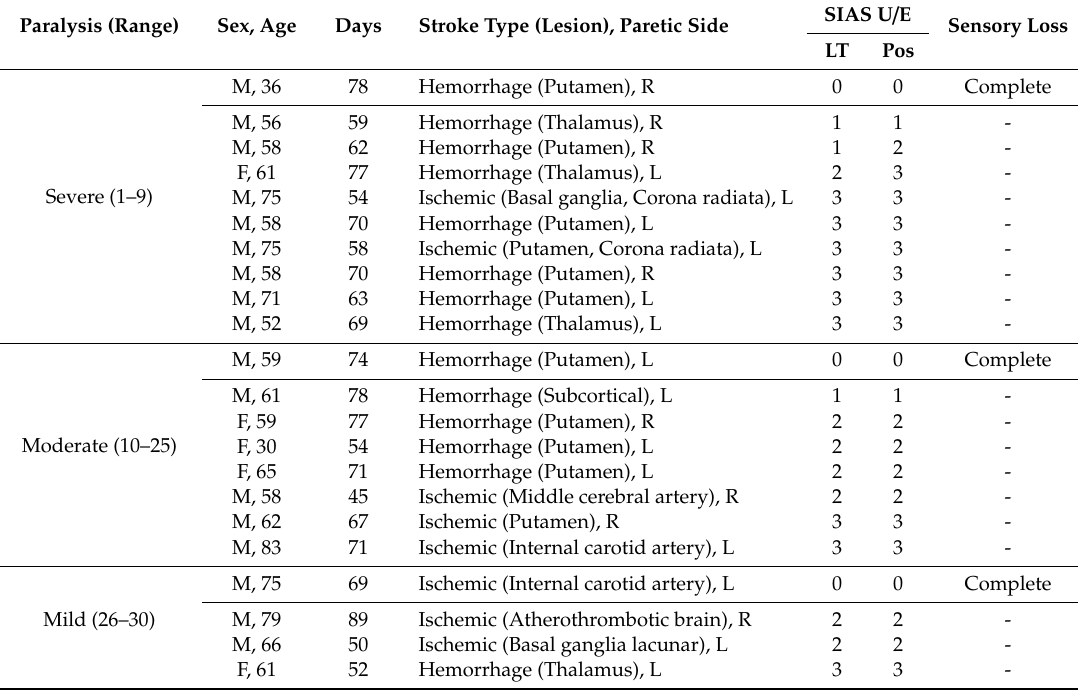
Table 1. Characteristics of participants at the start of robot